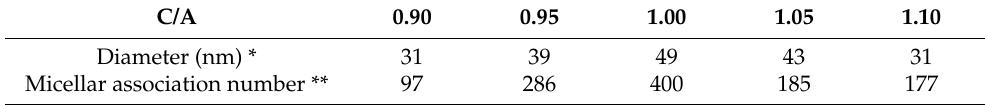
Table 1. Structural characteristics features of PIC/m prepared with different mixing molar ratios of